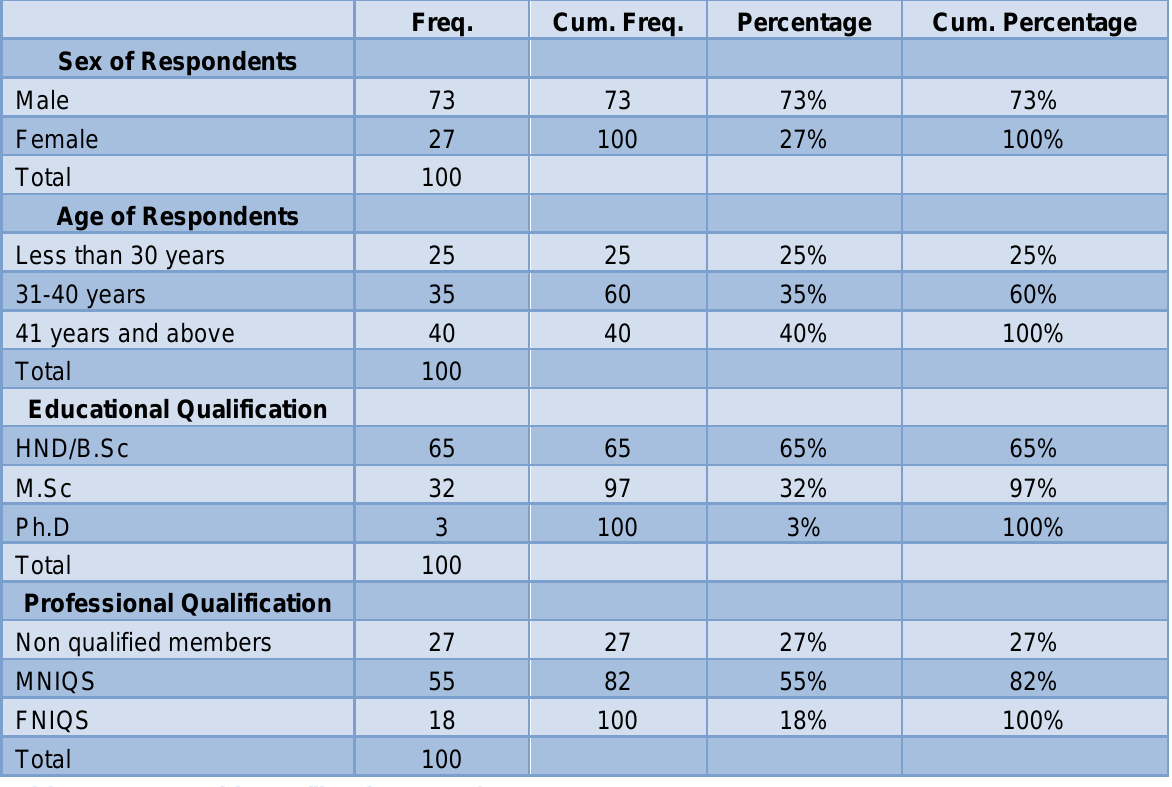
Table 1 Demographic Profile of Respondents Relationship between Overall Job Satisfaction and Facets of Job Satisfaction